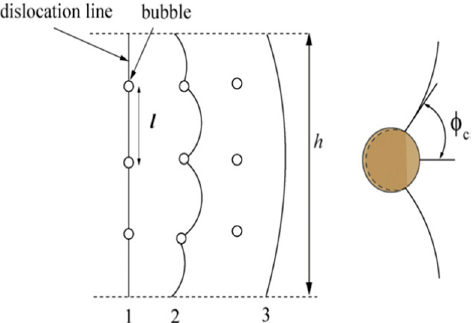
Figure 19. Schematic illustration of glide dislocation interactions with nanometer-scale bubbles with the spacing of l . Numbers 1–3 show the steps of dislocation movement across the bubbles. φ c is the semi-critical angle at which the dislocation breaks away from the pinning points [96].